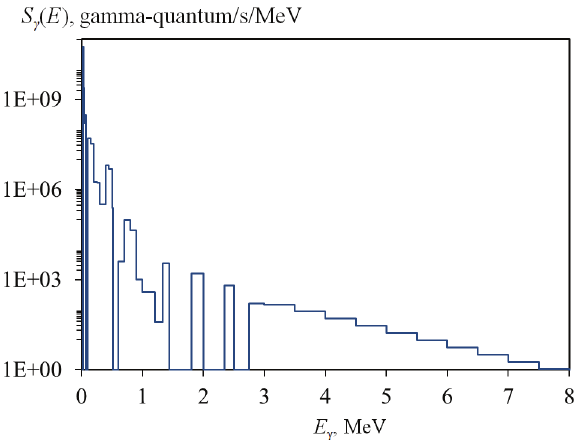
Figure 7. Energy spectrum of the photon